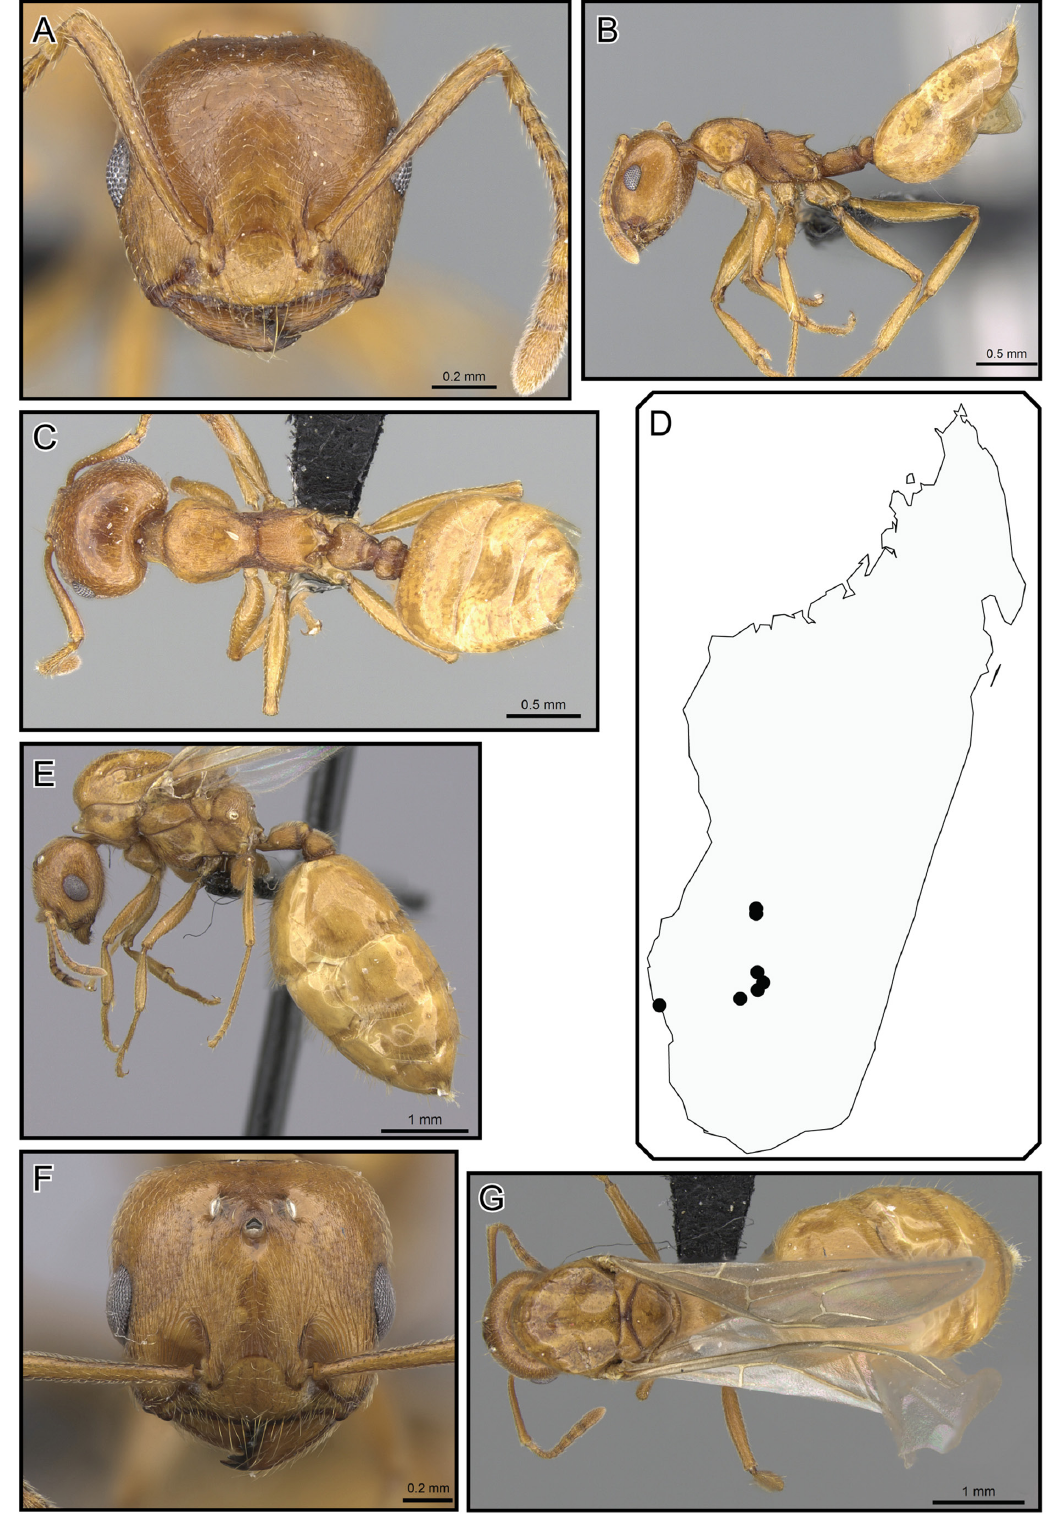
Fig. 7. Crematogaster bara sp. nov., worker, queen and distribution. A-C. Worker (CASENT0491123). A. Full-face. B. Profile. C. Dorsal. D. Species distribution. E-G. Queen (CASENT0064664). E. Profile. F. Full-face. G.